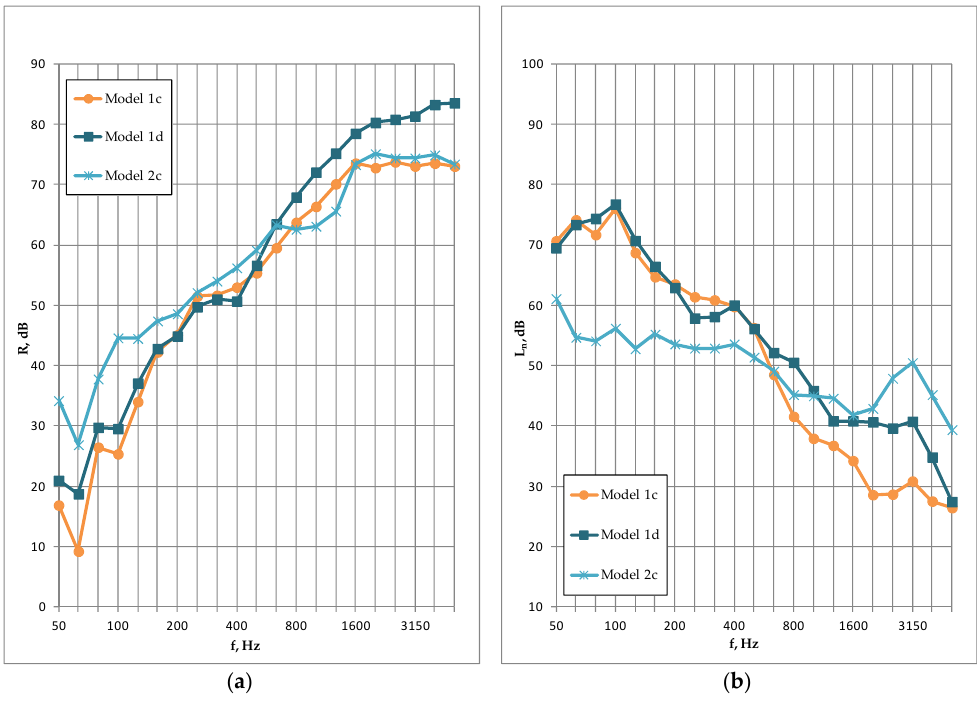
Figure 12. Airborne ( a ) and impact ( b ) sound insulation test results of both floor structures.